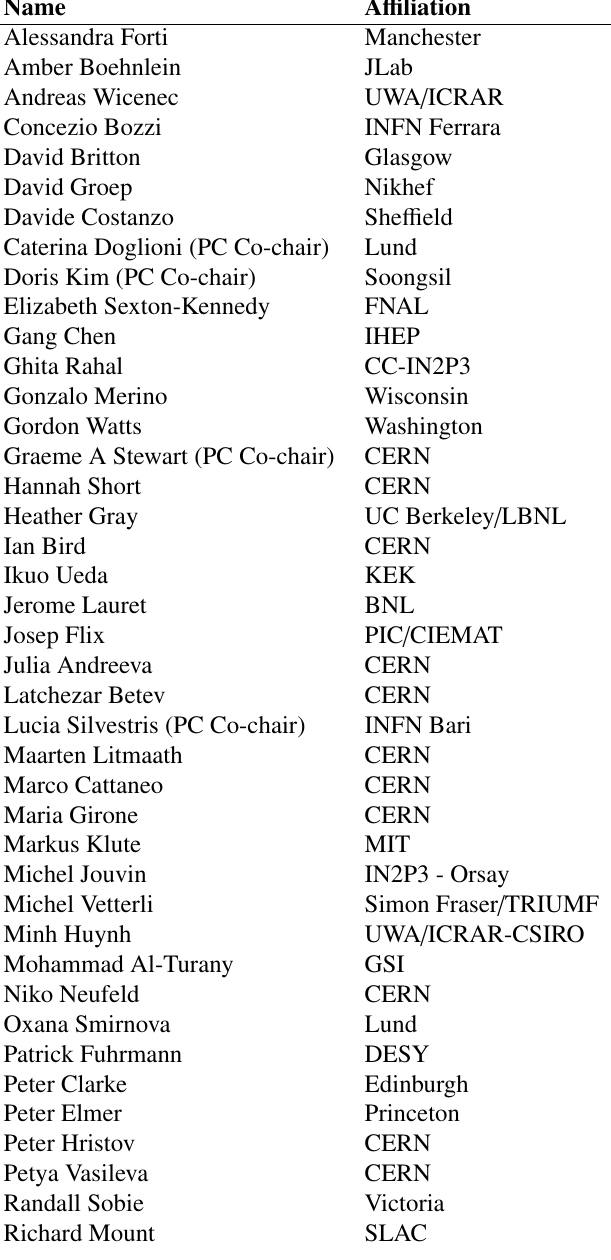
Table 4: CHEP 2019 International Advisory